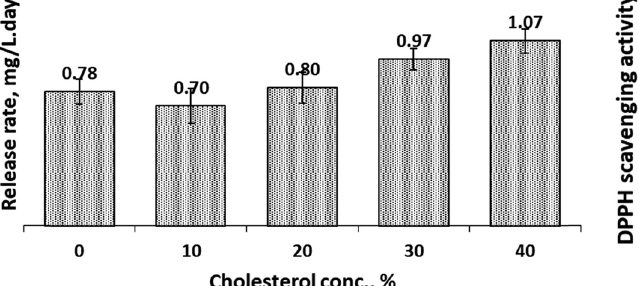
Figure 9: Release rate of Cur from cocoliposome in SIF solution as a function of cholesterol.